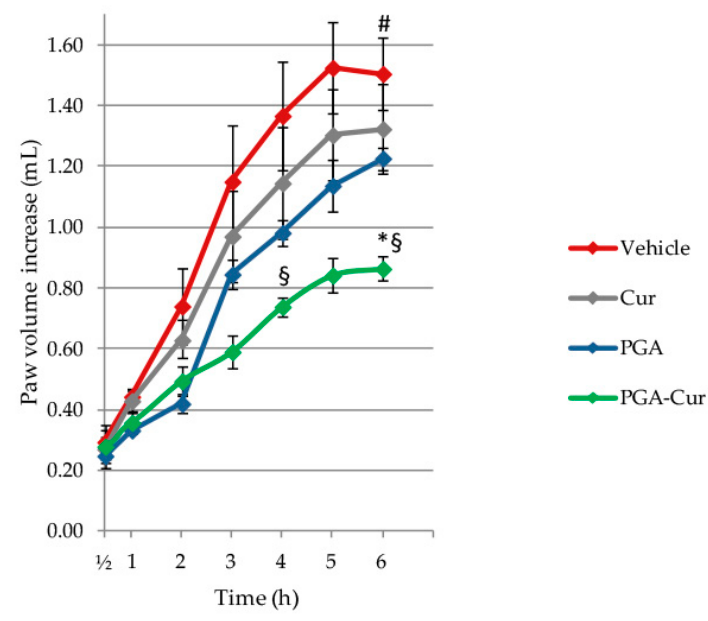
Figure 1. Anti-inflammatory effect of palmitoyl-glucosamine (PGA) and curcumin (Cur) given individually or in a co-micronized formulation (PGA-cur) on carrageenan-induced paw edema. Inflammation was assessed as paw volume increase (mL) after CAR injection relative to pre-injection value (i.e., basal condition). Results are expressed as means ± standard error of the mean (SEM) (N = 6 animals / group). PGA = micronized palmitoyl-glucosamine. # p < 0.0001 vs. basal condition; * p < 0.05 vs. vehicle; § p < 0.05 vs. PGA.